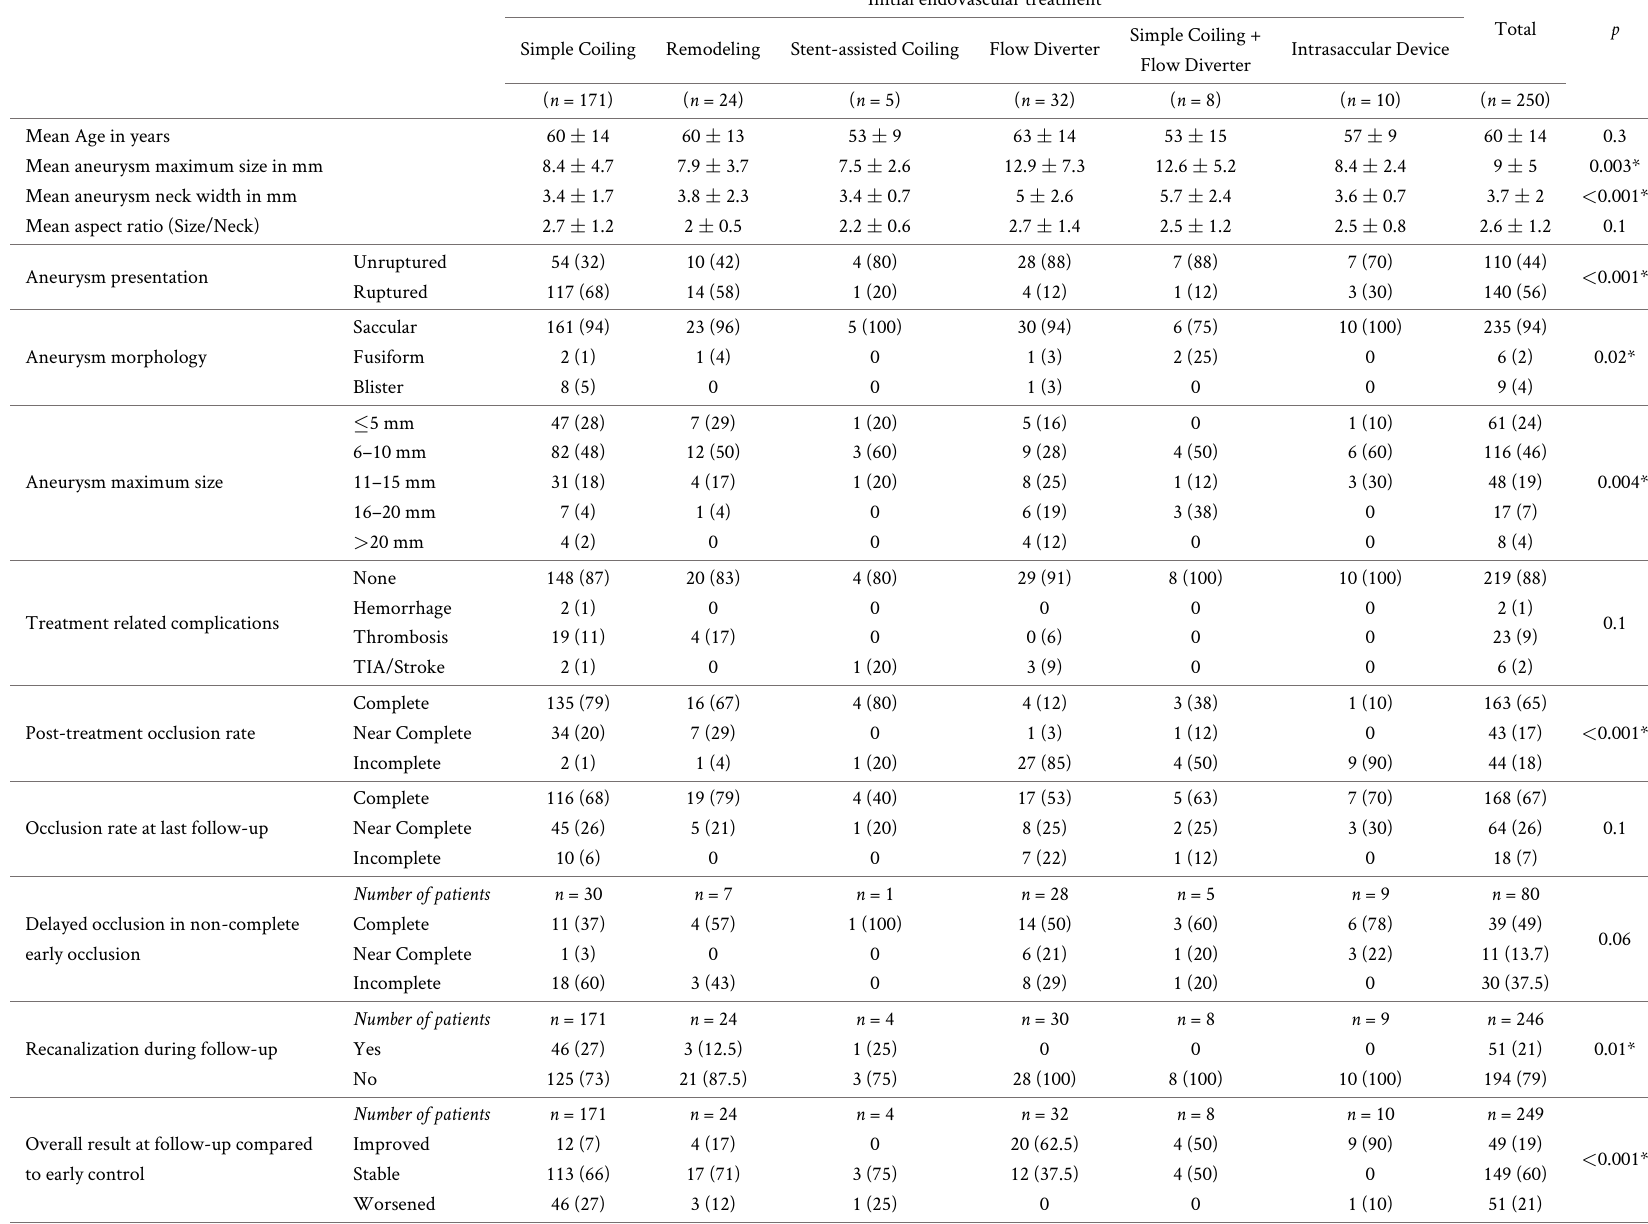
Table 3. Results according to initial endovascular